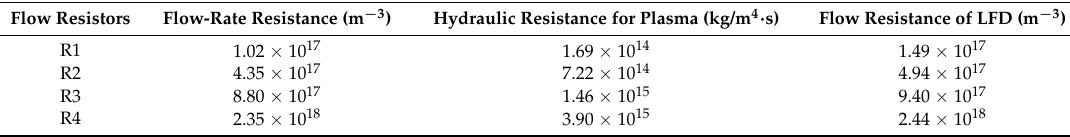
Table 1. List of integrated flow resistors with different flow-rate resistances and hydraulic resistances and corresponding flow resistances of